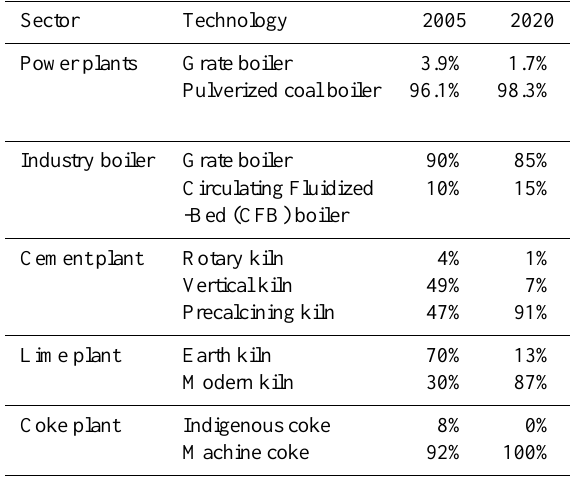
Table 4. Technology changes of selected industrial